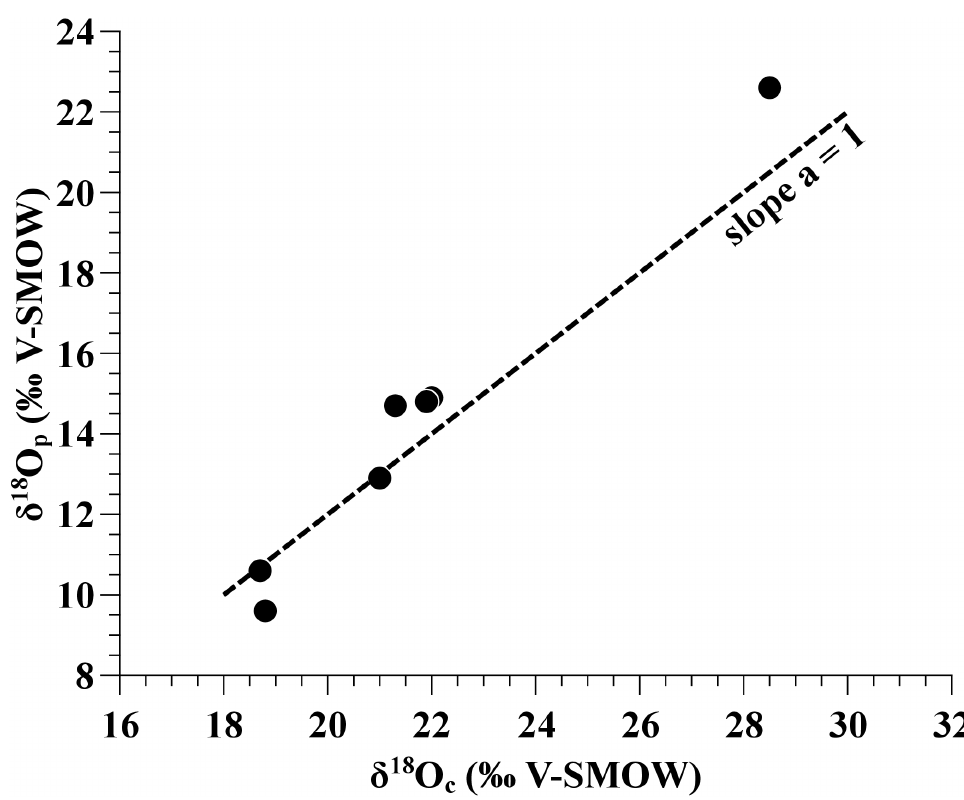
Figure 2. Oxygen isotope compositions of structural carbonate ( δ 18 O c ) of all analyzed vertebrate apatites plotted against their corresponding oxygen isotope compositions of phosphate ( δ 18 O p ).